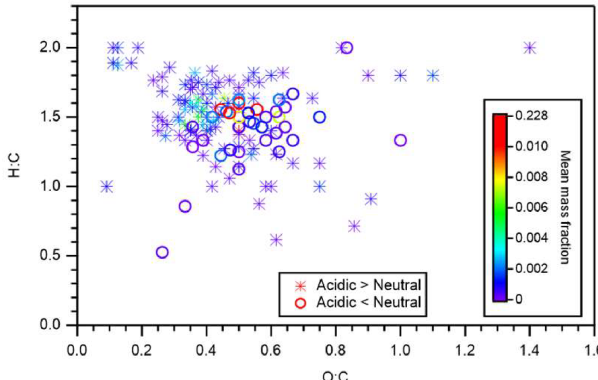
Figure 6. Atomic H-to-C ratio (H : C) versus O-to-C ratio (O : C). Stars and circles respectively indicate compounds whose particle- phase mass fractions under acidic seed conditions were more than 1.1 and less than 0.9 times those of neutral seed conditions. The color scale indicates the mean mass fraction of identified com- pounds across all six experiments. Notably, organosulfates were not